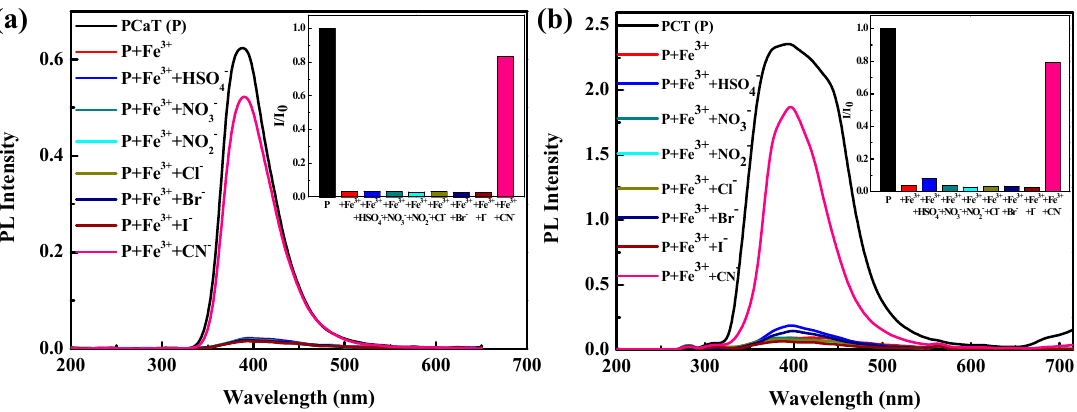
Figure 6. Photoluminescence spectra of ( a ) PCaT ‒ Fe 3+ and ( b ) PCT ‒ Fe 3+ in the presence of various anions. Inset: photoluminescence response profiles of polymer ‒ Fe 3+ in the presence of various anions. Polymers 2017 , 9 , 427